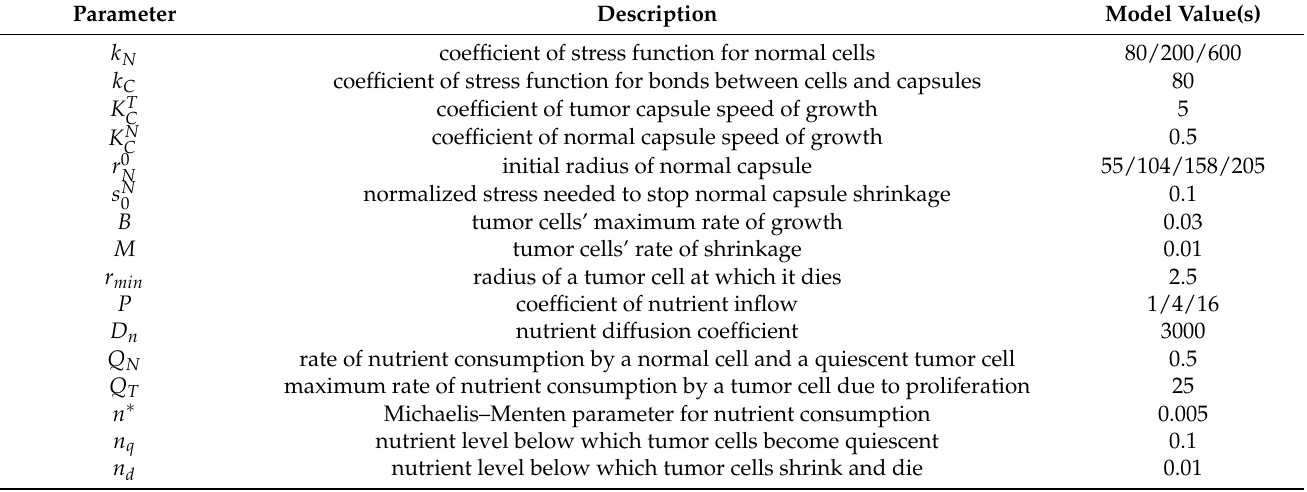
Table 2. Additional model parameters that were used in the simulations of tumor growth in